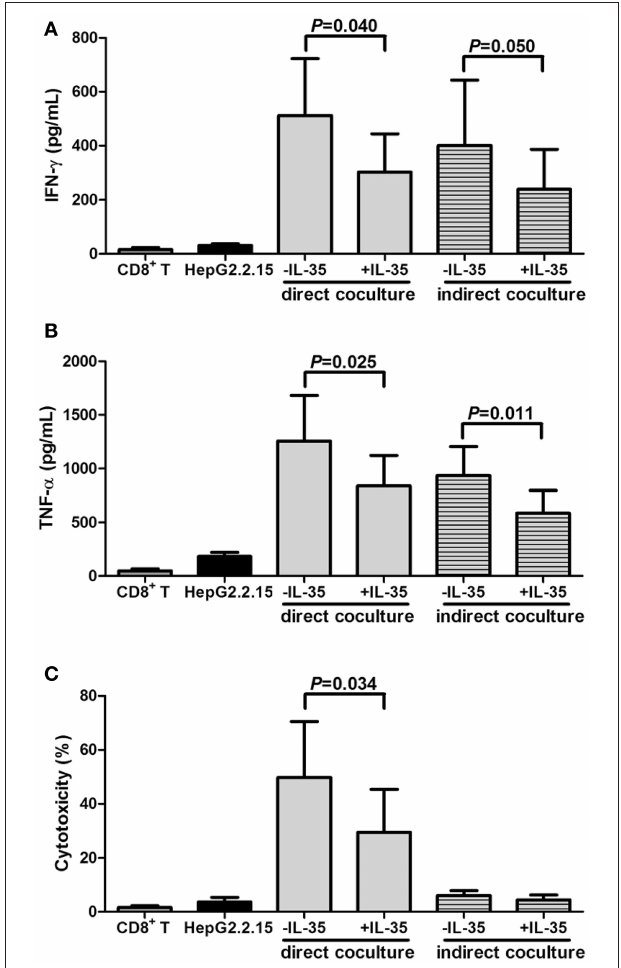
FIGURE 5 | Interleukin (IL)-35 stimulation suppressed cytolytic and noncytolytic function of CD8 + T cells in chronic hepatitis B (CHB, n = 9). Purified CD8 + T cells from HLA-A2 restricted CHB patients were co-culture with HepG2.2.15 cells in the presence or absence of IL-35 with HBc 18-27 peptide stimulation in either direct or indirect contact culture system. As controls, HepG2.2.15 cells were cultured alone, and CD8 + T cells were stimulated with HBc 18–27 peptide. The concentrations of interferon- γ (IFN- γ ) (A) and tumor necrosis factor- α (TNF- α ) (B) in the supernatants were measured by Human Proinflammation 7-Plex Base Kit using SECTOR Imager. (C) Percentage of cell death was measured by lactate dehydrogenase (LDH) release. The data were presented as mean ± SD, and significances were calculated using paired t-